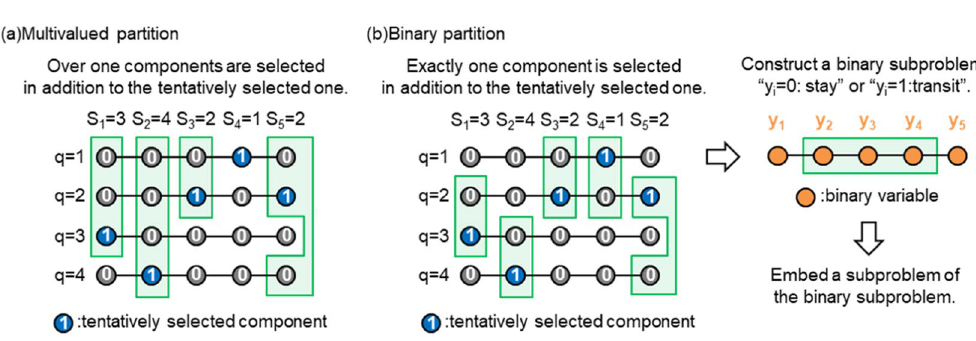
Figure 2. Proposed methods for finding superior solutions to large optimization problems under the one-hot